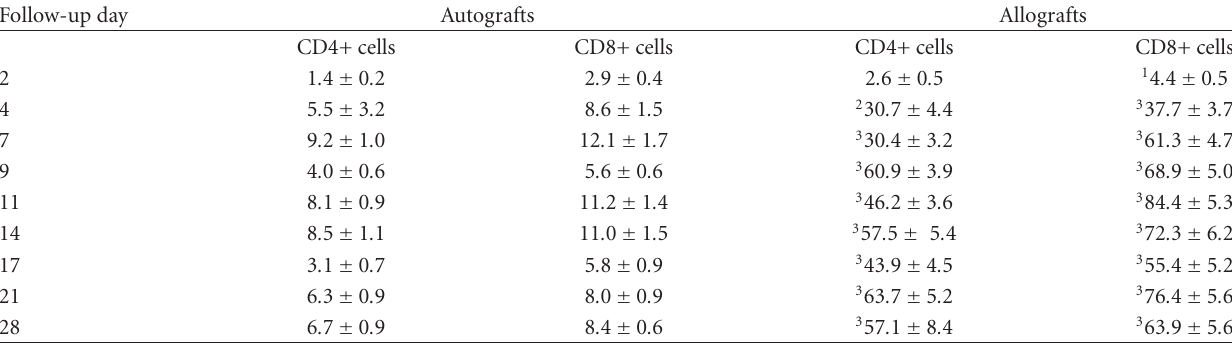
Table 1: Immune cell influx in bronchial autografts and allografts. An early influx of CD4+ and CD8+ cells with CD8+ cell predominance indicates an immune response in the bronchial allografts.